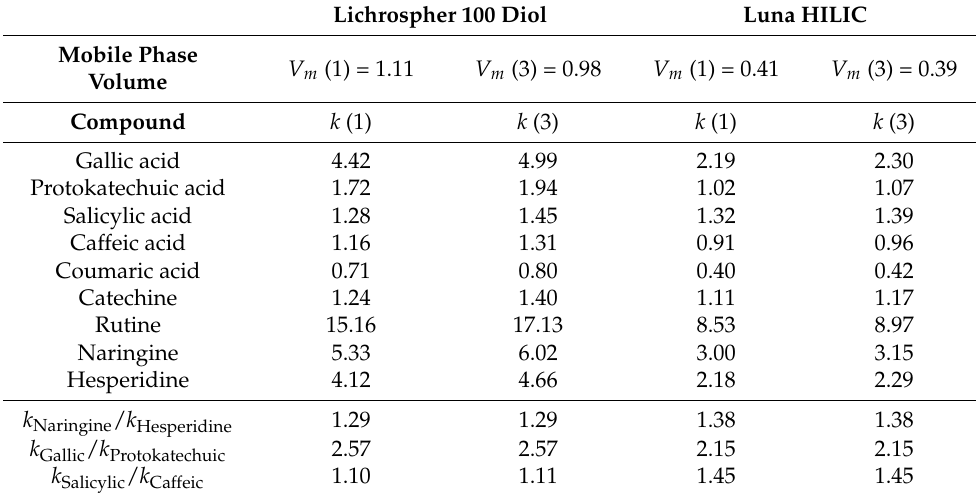
Table 3. Effects of the stationary phase volume convention 1 ((1)—solid phase)) and convention 3 ((3)— sorbed water)) on the hold-up volume, V m , retention factors, k i and selectivity (relative retention, k j /k i ) on the Lichrospher100 Diol and Luna HILIC columns in 98%